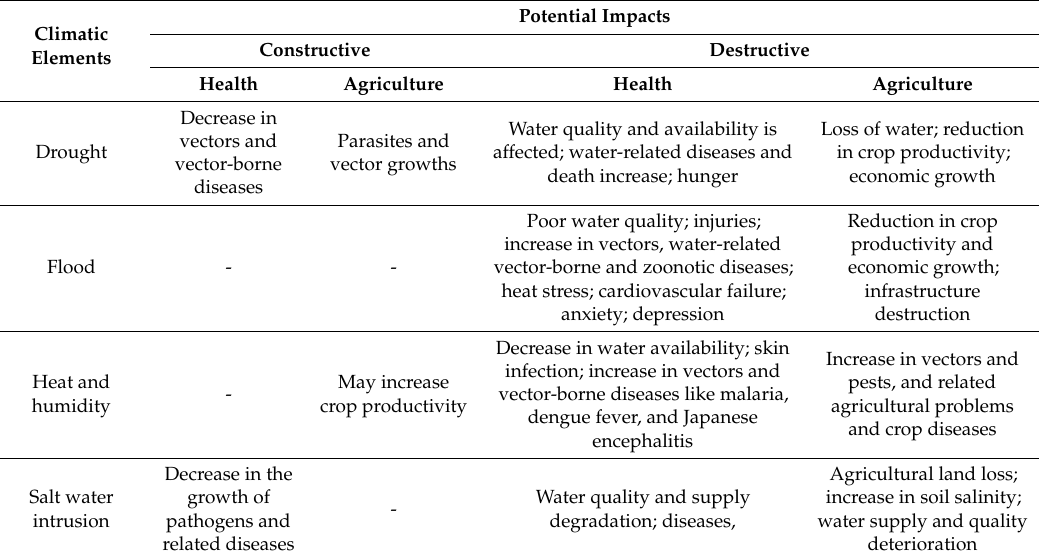
Table 4. Potential impact of major climatic elements on agriculture and health (based on this literature review and the expert opinions of the